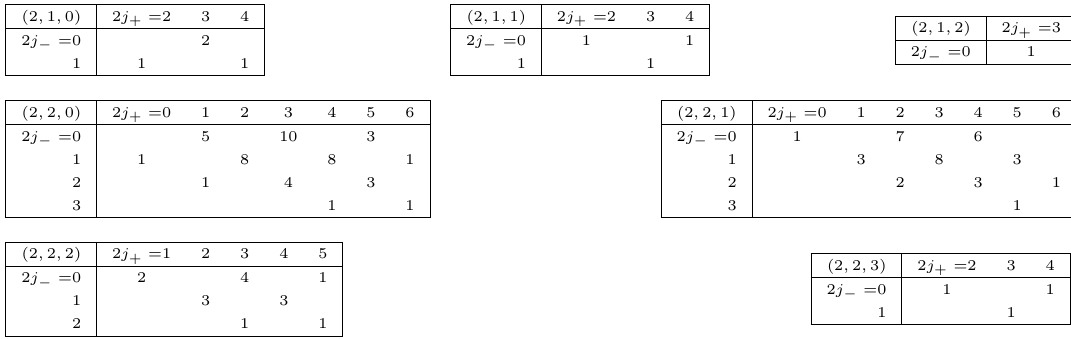
Table 15 . BPS numbers of massive M-string with base degree 2 and fiber degree 1 or 2.